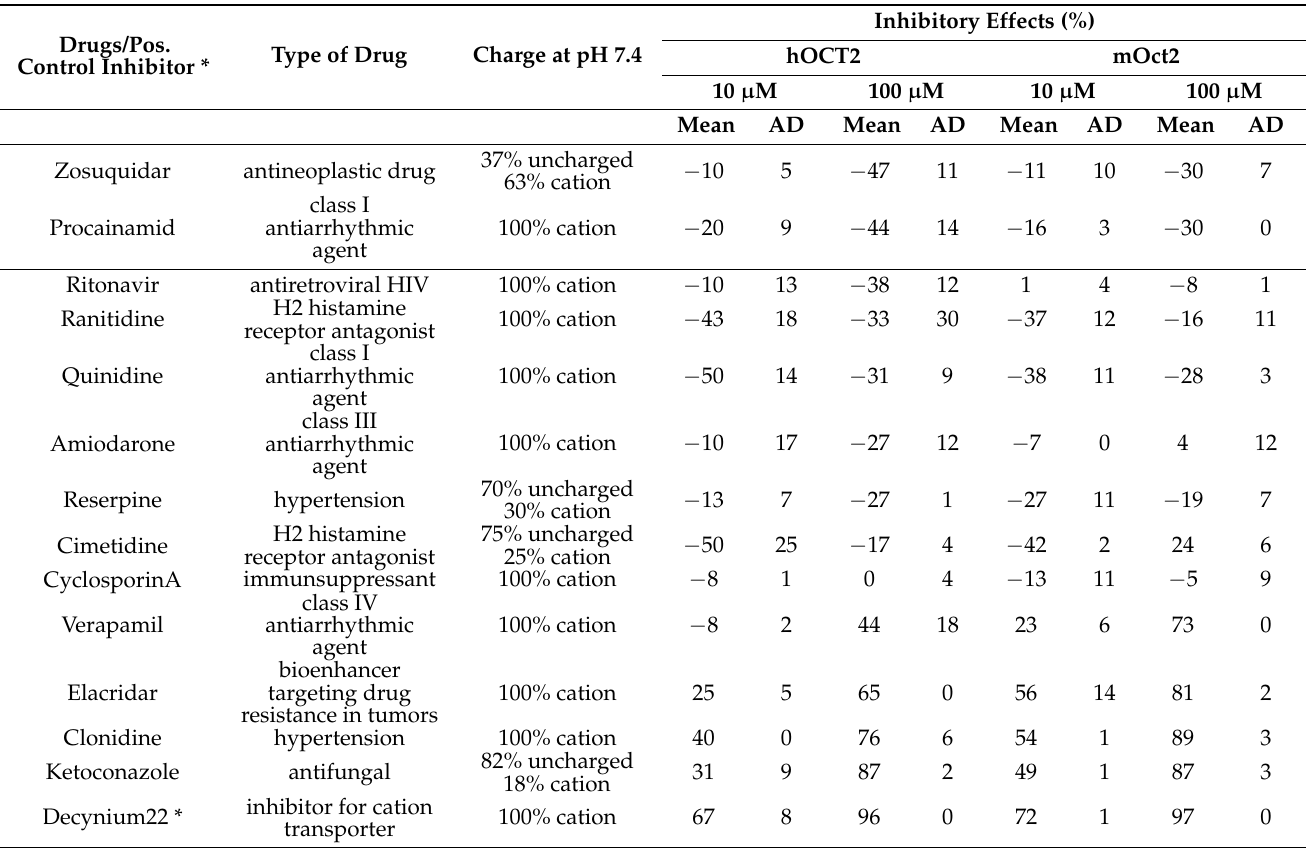
Table 1. Inhibitory effects (mean ± average deviation (AD)) of various drugs on hOCT2- and mOct2-mediated metformin-uptake. * Decynium22 is a control inhibitor for OCTs. Drugs/Pos. Control Inhibitor *